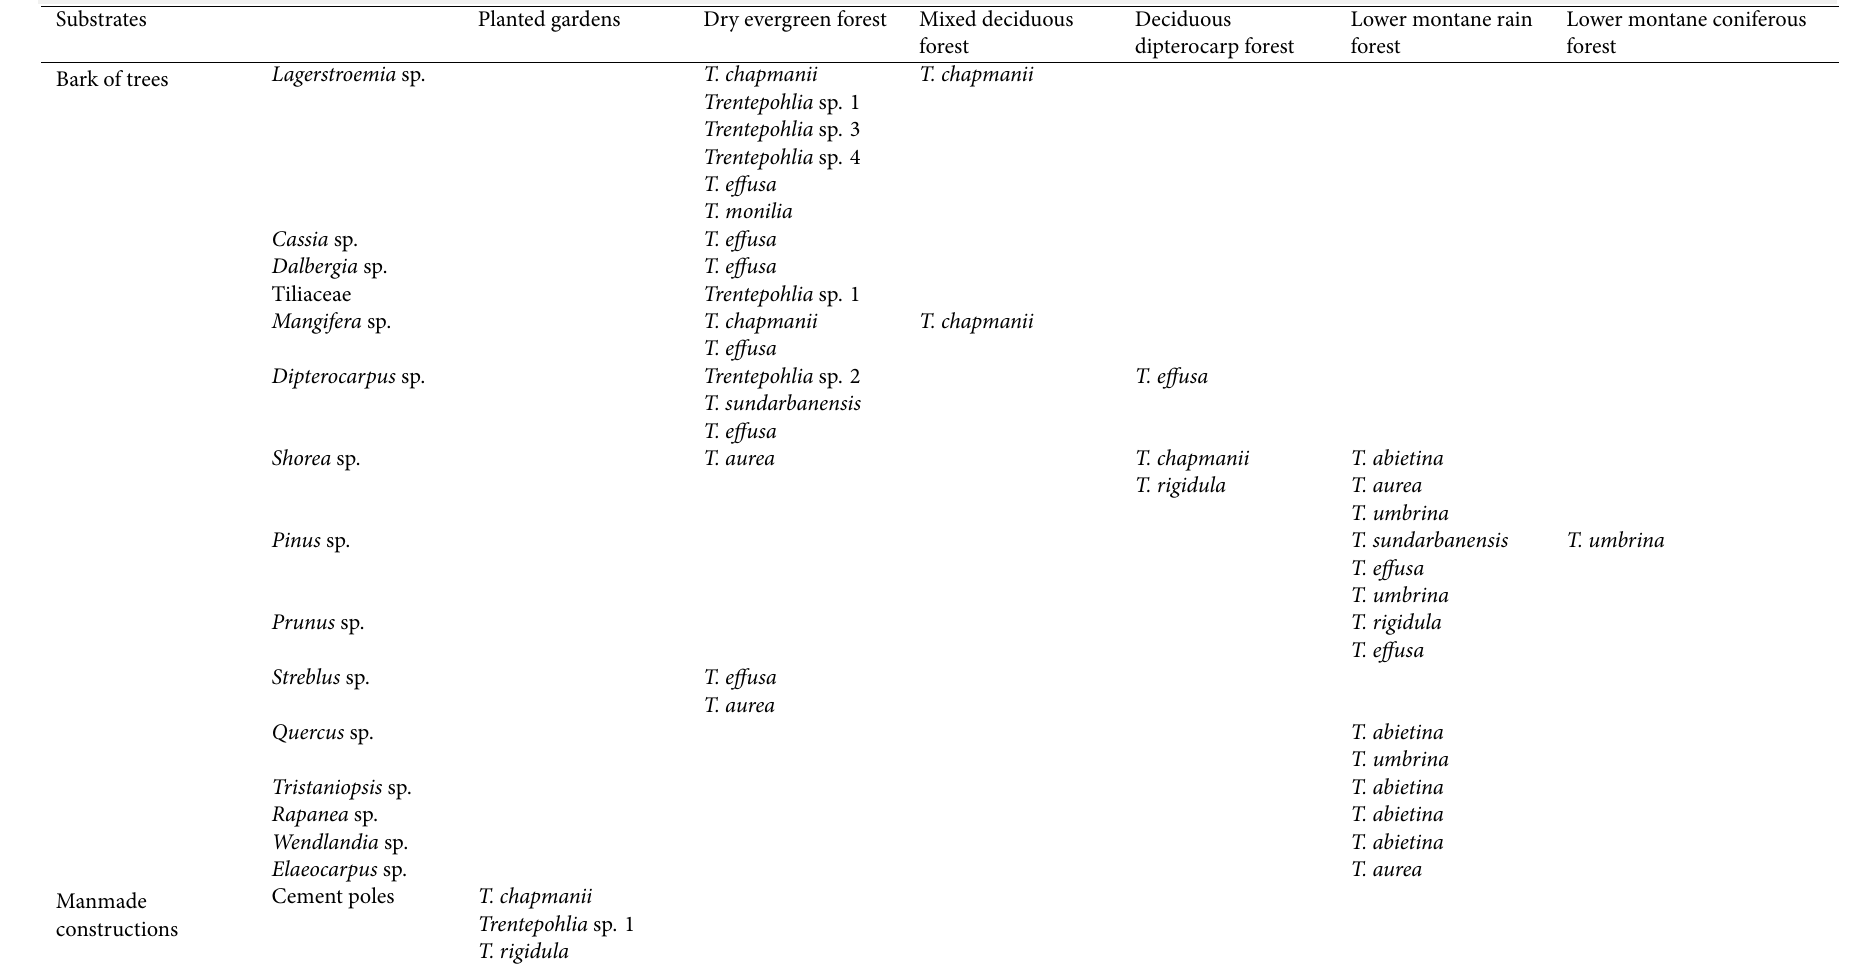
Table 2 Composition of the subaerial green algae genus Trentepohlia on different types of substrate and